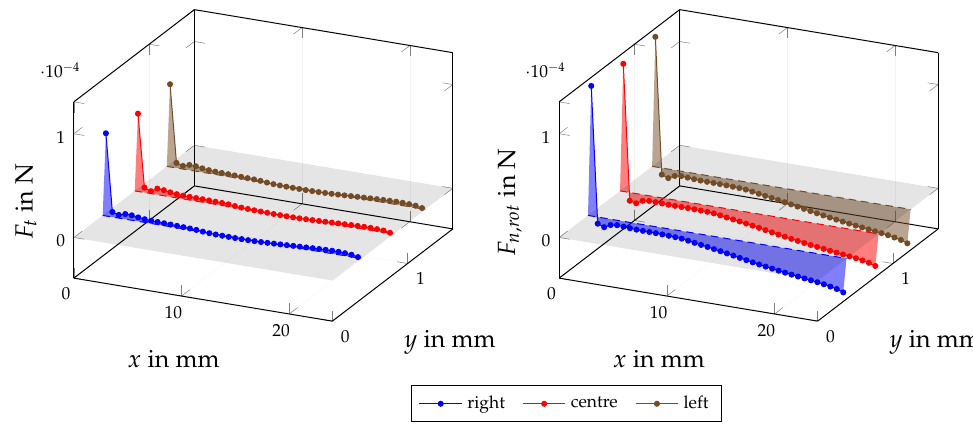
Figure 20. Two-dimensional distribution of tangential forces F t and rotation-induced normal forces F n , rot in a fragmented PM layer on one of four substrate walls. Differentiation between three lateral rows. Gray plane at zero crossing.